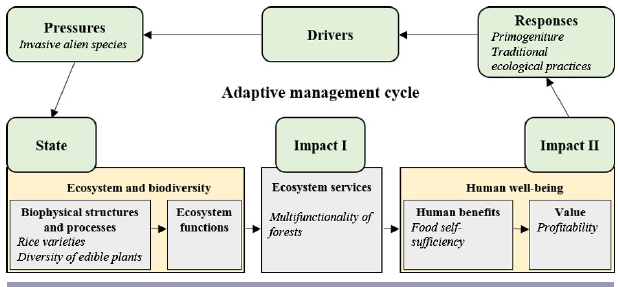
Fig. 2 . Adaptive management cycle of the Banaue social- ecological system. The eight indicators used in this study (in italics) represent different stages of the drivers-pressure-state- impact-response framework. Five of the indicators assess the dynamics of the “ecosystem services cascade” (state and impacts), two indicators represent responses, and one depicts pressures (adapted from Haines-Young and Potschin 2010, Müller and Burkhard 2012, Spangenberg et al.